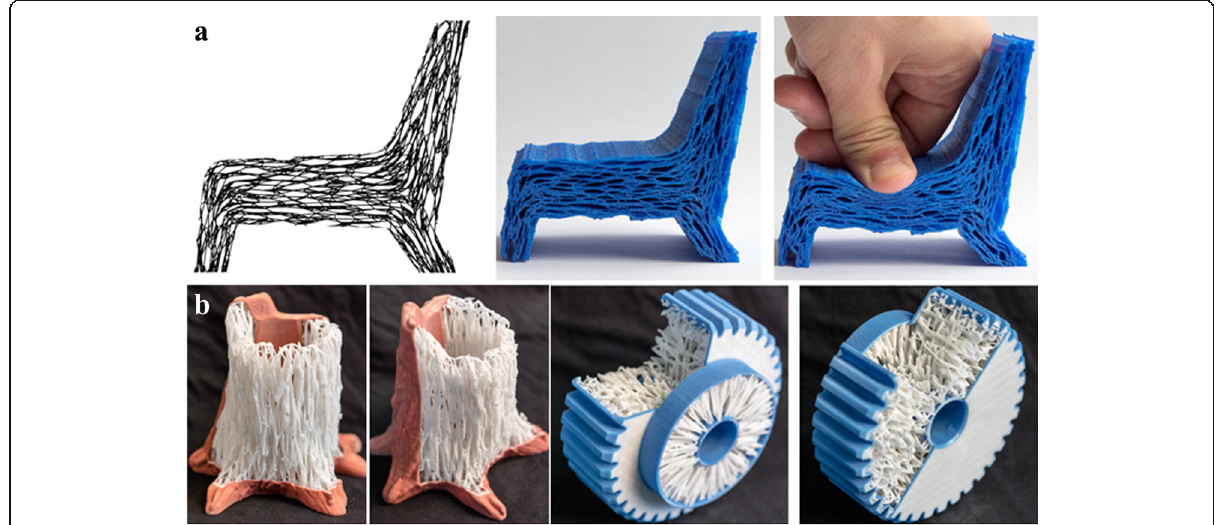
Fig. 7 Orthotropic k-nearest foam design: a Orthotropic design for loads from different directions. b Fabrication models with orthotropic filling structures